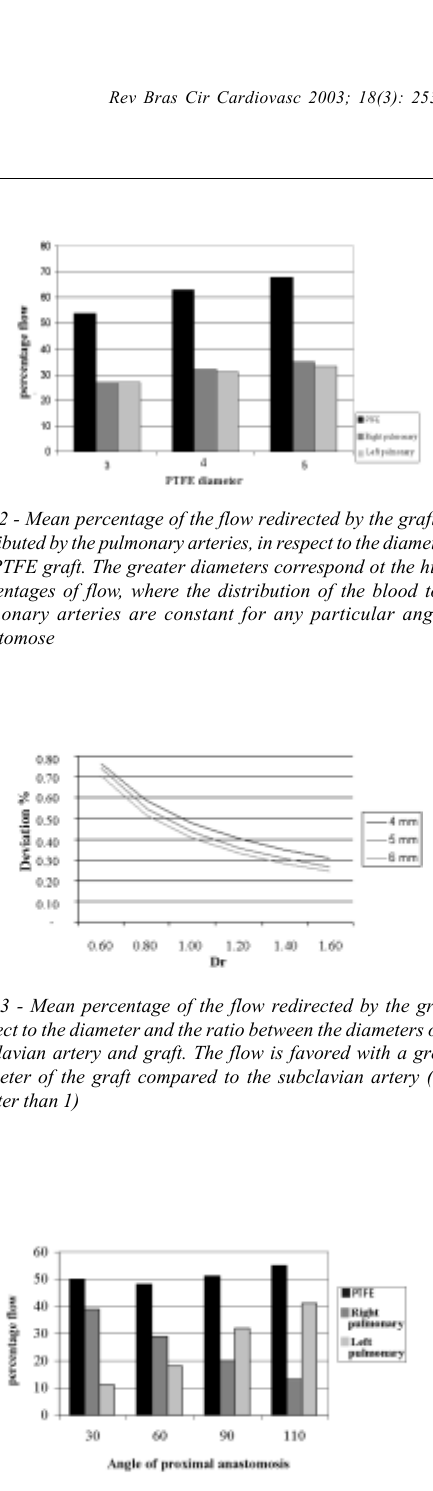
Fig. 4 - Mean percentage of the flow redirected by the graft and distributed by the pulmonary arteries, in respect to the proximal angle of the anastomosis. There is variability in the distribution of the flow in the pulmonary arteries depending on the angle of the